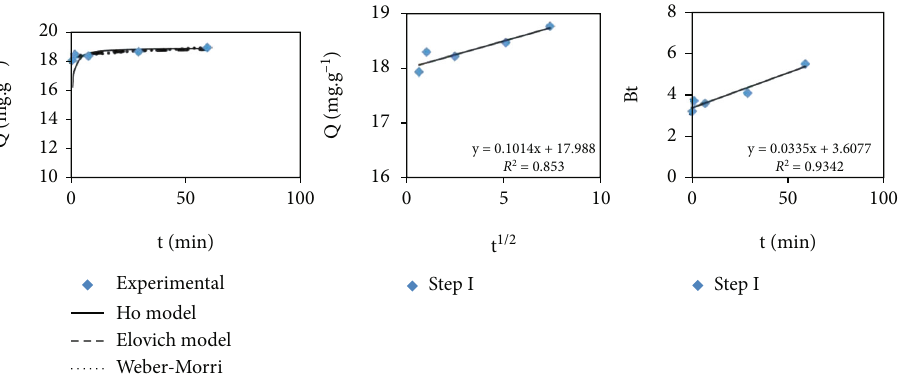
Figure 10: Experimental curves and the Ho, Elovich, and Webber-Morri models of the kinetic study of the adsorption of the Cd(II) ion in ferric clay.